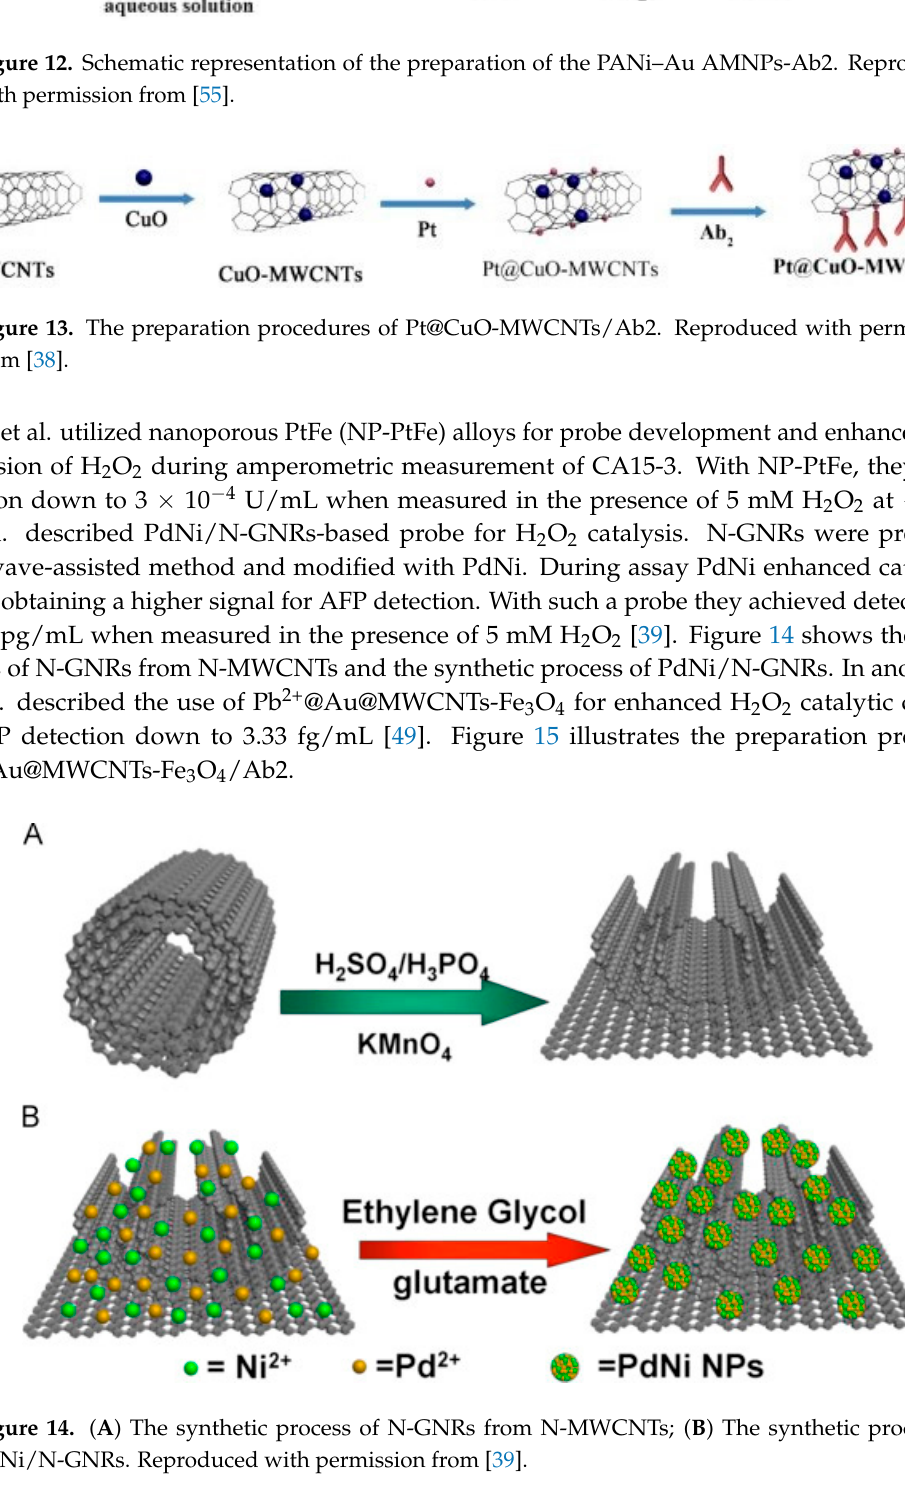
Figure 15. The preparation procedure of Pb 2+ @Au@MWCNTs-Fe 3 O 4 /Ab 2 . Reproduced with permission from [49]. Au/Ag/Au core/double shell nanoparticles (Au/Ag/Au NPs) as novel enzyme-mimetic labels for anti-SCCA have been described by Wang et al. The study showed that improved electrocatalytic activity of Au/Ag/Au NPs for H 2 O 2 reduction resulted in enhanced sensitivity and detection of SCCA down to 0.18 pg/mL [41]. For AFP estimation, Wei et al. described the use of anti-AFP tagged GO-CeO 2 and Pd nanoparticle-based probes. In such a Pd/APTES-M-CeO 2 -GS-based probe, Pd octahedral NPs showed enhanced catalytic activity for H 2 O 2 reduction and the sensor achieved detection down to 0.033 pg/mL when measured amperometrically at − 0.4 V in the presence of 5 mM H 2 O 2 [51]. Dumbbell shaped Pt–Fe 3 O 4 as labels were described by Wu et al. for SCC estimation. Results indicate that Pt–Fe 3 O 4 improve H 2 O 2 reduction and the immunosensor achieved linearity in the 0.05–18 ng/mL range with a detection limit of 15.3 pg/mL [65]. In other study, Wu et al. described the use of a dumbbell-shaped PtPd-Fe 3 O 4 nanoparticles-based label in designing immunosensor for CA72-4 biomarker for gastric cancer. Results indicated that PtPd–Fe 3 O 4 improve H 2 O 2 reduction and immunosensor achieved linearity in the 0.001–10 U/mL range with detection limit of 0.0003 U/mL [67]. Li et al. described the mesoporous core-shell Pd@Pt nanoparticles loaded by amino group functionalized graphene (M-Pd@Pt/NH 2 -GS)-based detection. With such a probe, they achieved higher reduction of H 2 O 2 to improve the sensitivity of the immunosensor. In immunoassay for PSA